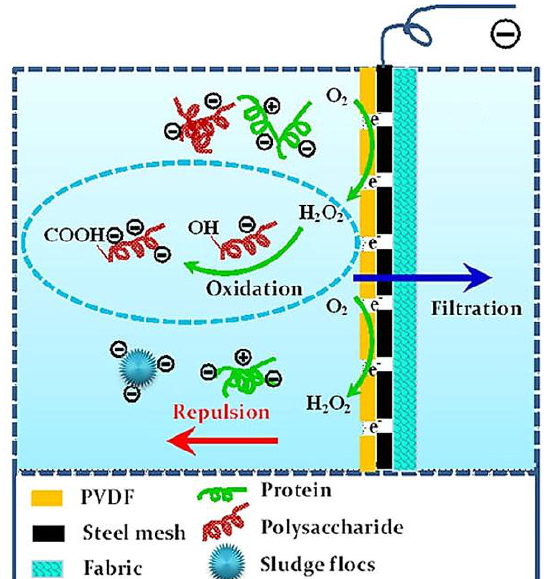
Figure 7. Schematic illustration of anti-fouling mechanism. Reprinted from [116], with permission from Nature Publishing Group.